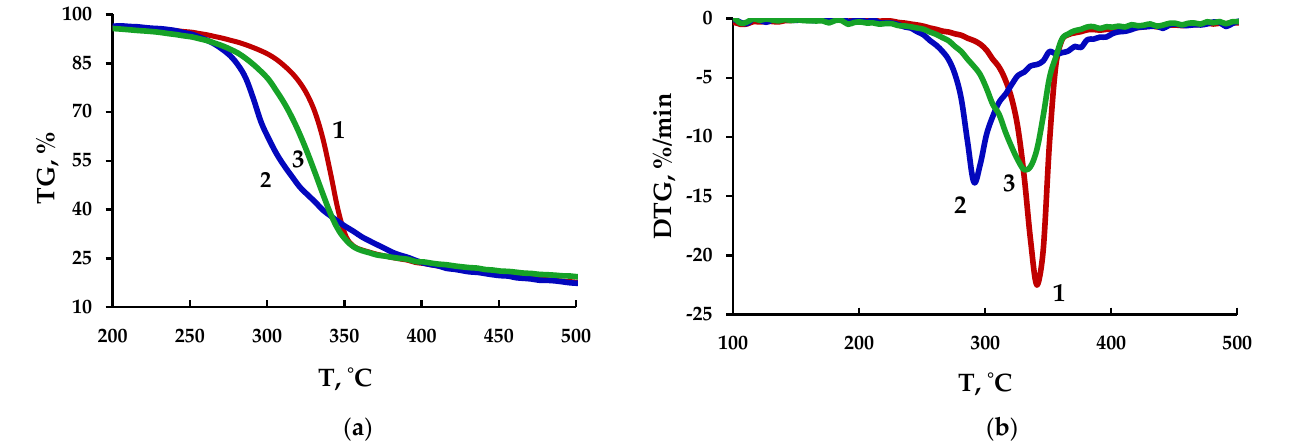
Figure 10. Curves ( a ) of TG and ( b ) DTG of cellulose samples: 1 – initial cellulose; 2 – MCC; 3 – MFC.